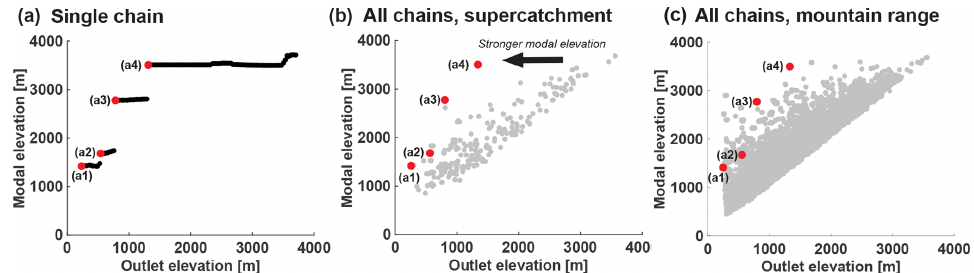
Figure 5. Mapping single progressive hypsometry chains on the mountain range scale. (a) Same as Fig. 4b. Modal elevation is calculated for subcatchments progressively extracted along single chain. (b) On the scale of a super-catchment (e.g., Fig. 4a), jumps in modal elevation for each chain are plotted corresponding to the outlet elevation at which the jump occurs ( h_change ). Red points are the same as panel (a) and correspond to catchments in Fig. 4c–f. (c) Same as panel (b) , except for all chains in entire mountain range (Talamanca Range, Costa Rica).